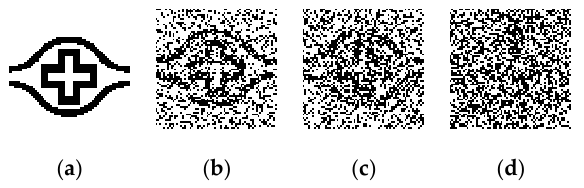
Figure 3. Distorted watermark images with different normalized correlation (NC) values. ( a ) Original image, ( b ) distorted watermark 1 (NC = 0.87), ( c ) distorted watermark 2 (NC = 0.77), and ( d ) distorted watermark 3 (NC = 0.67).